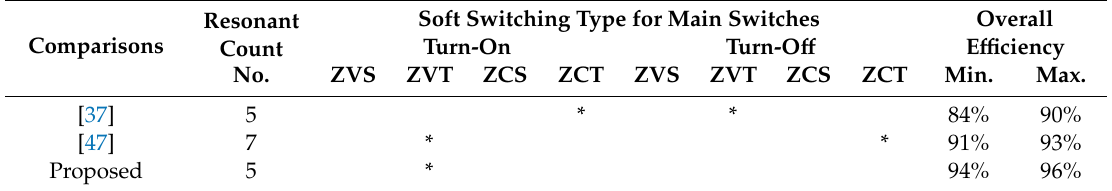
Table 2. Comparisons between the circuits from [37], [47] and the proposed circuits (ZVS: zero-voltage switching; ZVT: zero-voltage transition; ZCS: zero-current switching; ZCT: zero-current transition). Soft Switching Type for Main Switches Overall Resonant Comparisons E ffi ciencyTurn-On Turn-O ff Count No. ZVS ZVT ZCS ZCT ZVS ZVT ZCS ZCT Min. Max. [37] 5 * * 84% 90% [47] 7 * * 91% 93% Proposed 5 * 94%